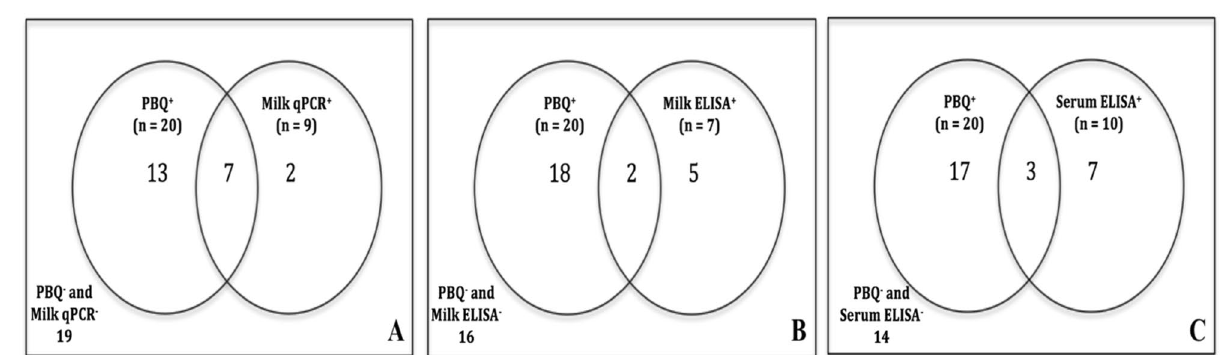
Figure 1. Venn comparison analysis between phage bead qPCR (PBQ) dataset and each MAP diagnostic assay of milk qPCR ( A ), milk ELISA ( B ), and serum ELISA ( C